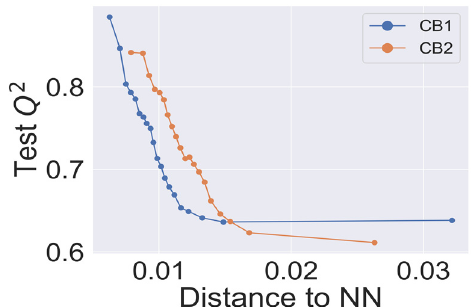
Figure 3. Q 2 —applicability domain threshold dependence for CB1 and CB2 k-nearest neighbor (kNN) models. Each point on the curves represents a Q 2 calculated for external predictions for a cumulative fraction of molecular structures in the training dataset within a step of 5%.